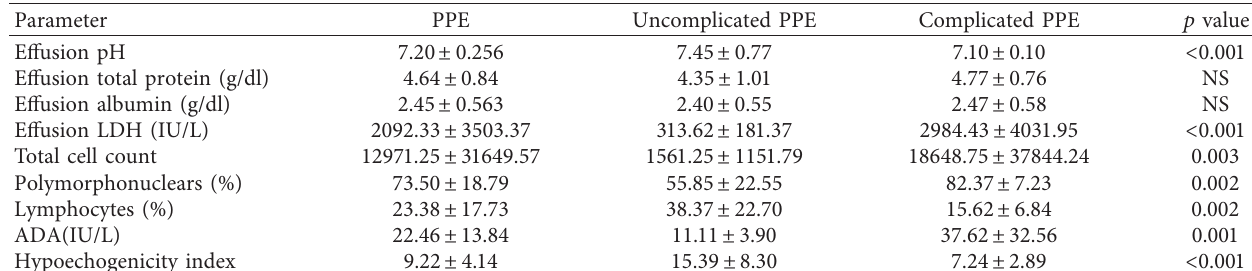
Table 2: Pleural fluid characteristics of the study population. Data are expressed as mean ± SD or as absolute numbers. PPE, parapneumonic